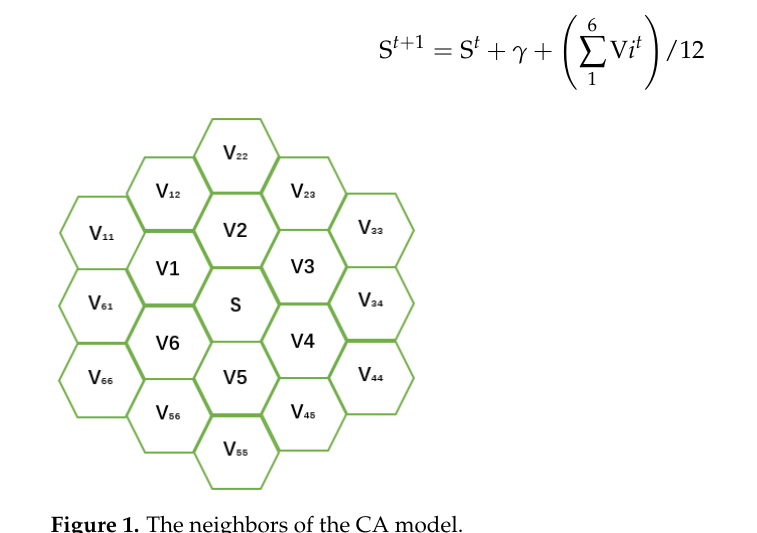
Figure 1. The neighbors of the CA model.